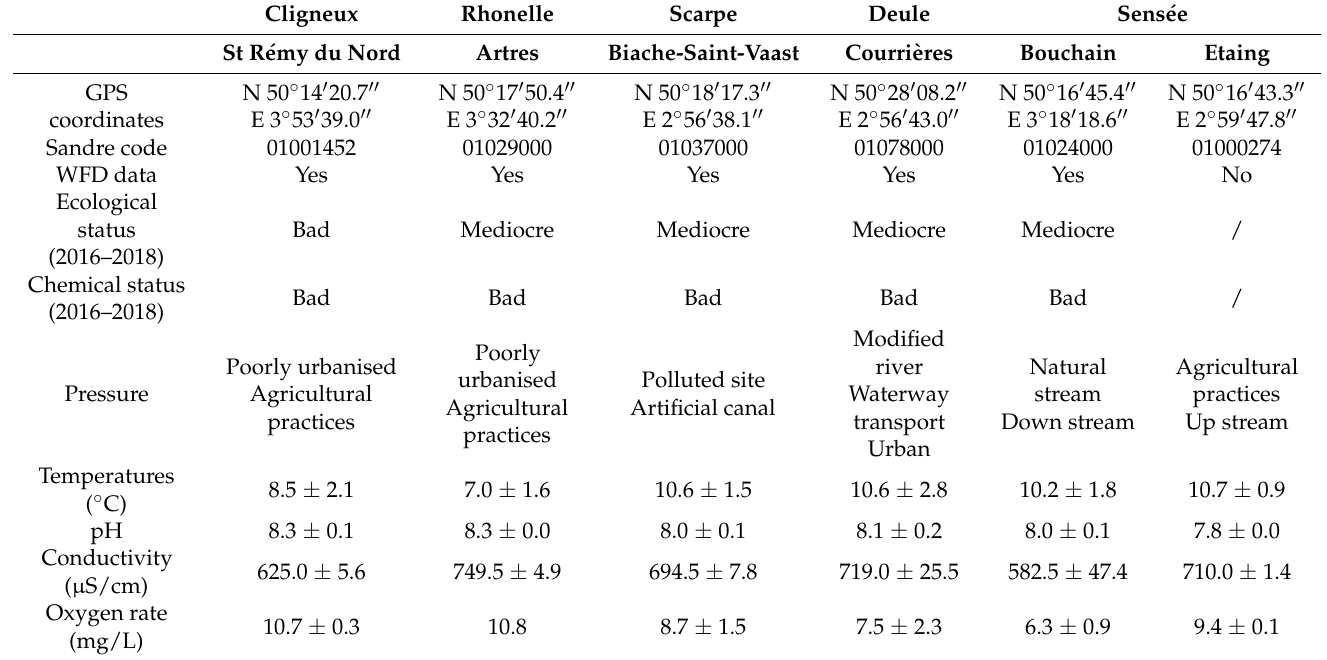
Table 1. Characteristics of sites located on the Artois-Picardie watershed: physicochemical parameters measured are expressed as means ± standard deviation; ecological and chemical statuses were collected from the Water Agency of Artois-Picardie databases and are defined by the Water Agency under the evaluation criteria of the Water Framework Directive (WFD, 2000/60/EC). Rhonelle Scarpe Deule Sens é e Artres Biache-Saint-Vaast Courri è res Bouchain